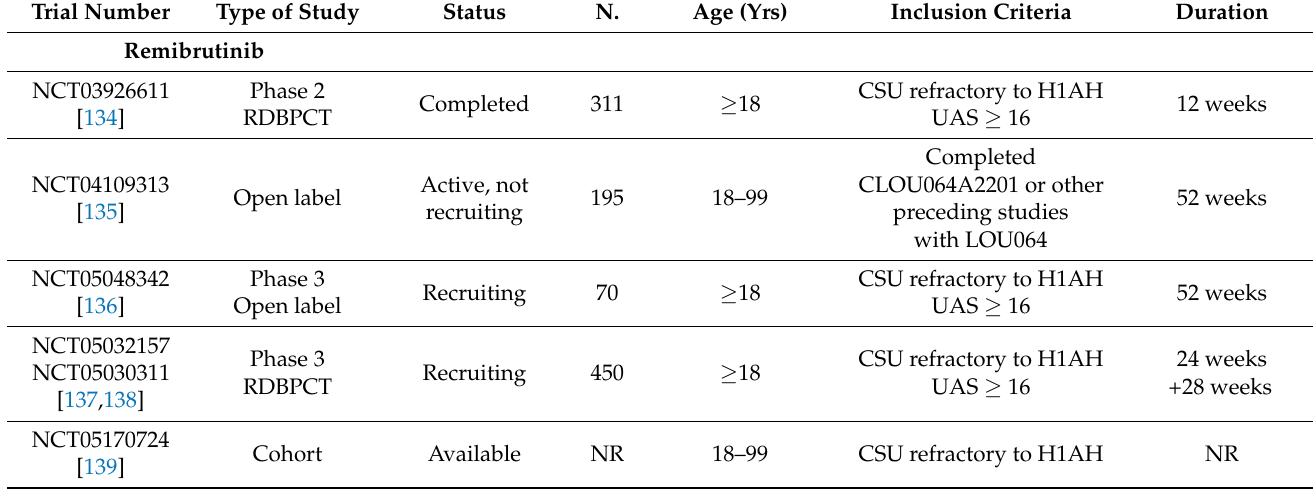
Table 7. List of the trials on small molecules